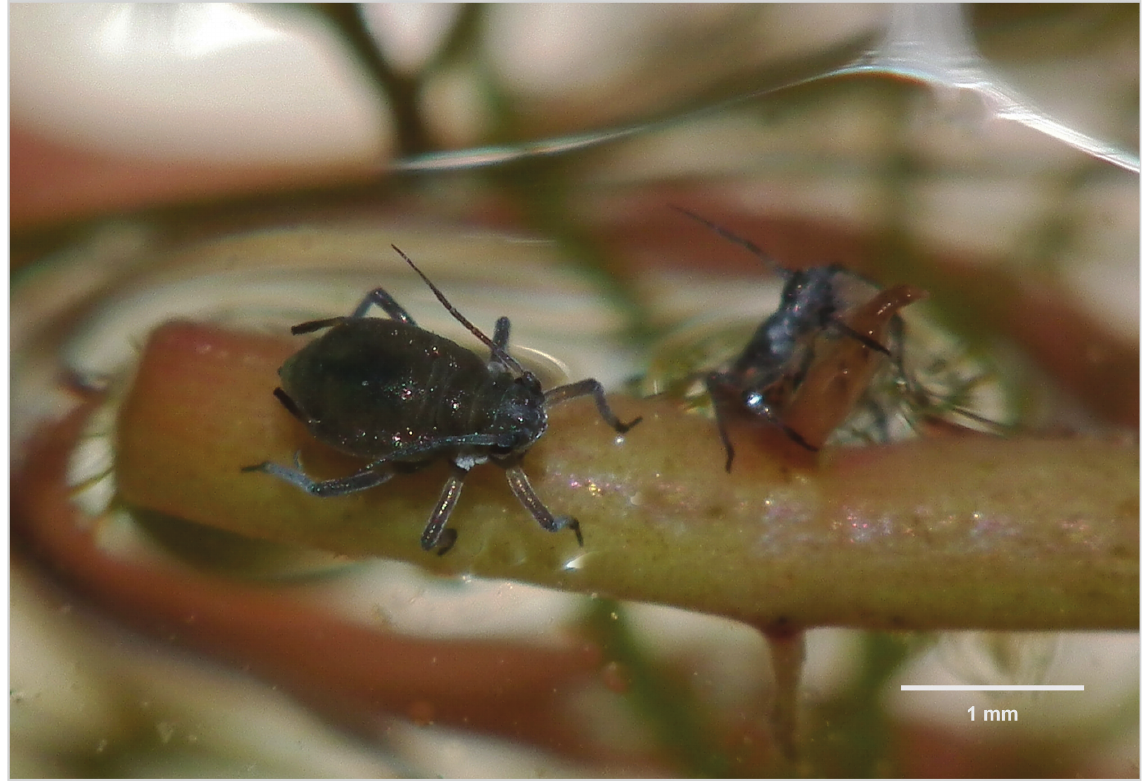
Fig. 33. Rhopalosiphum nymphaeae (linnaeus, 1761). Aptera on Myripohyllum spicatum